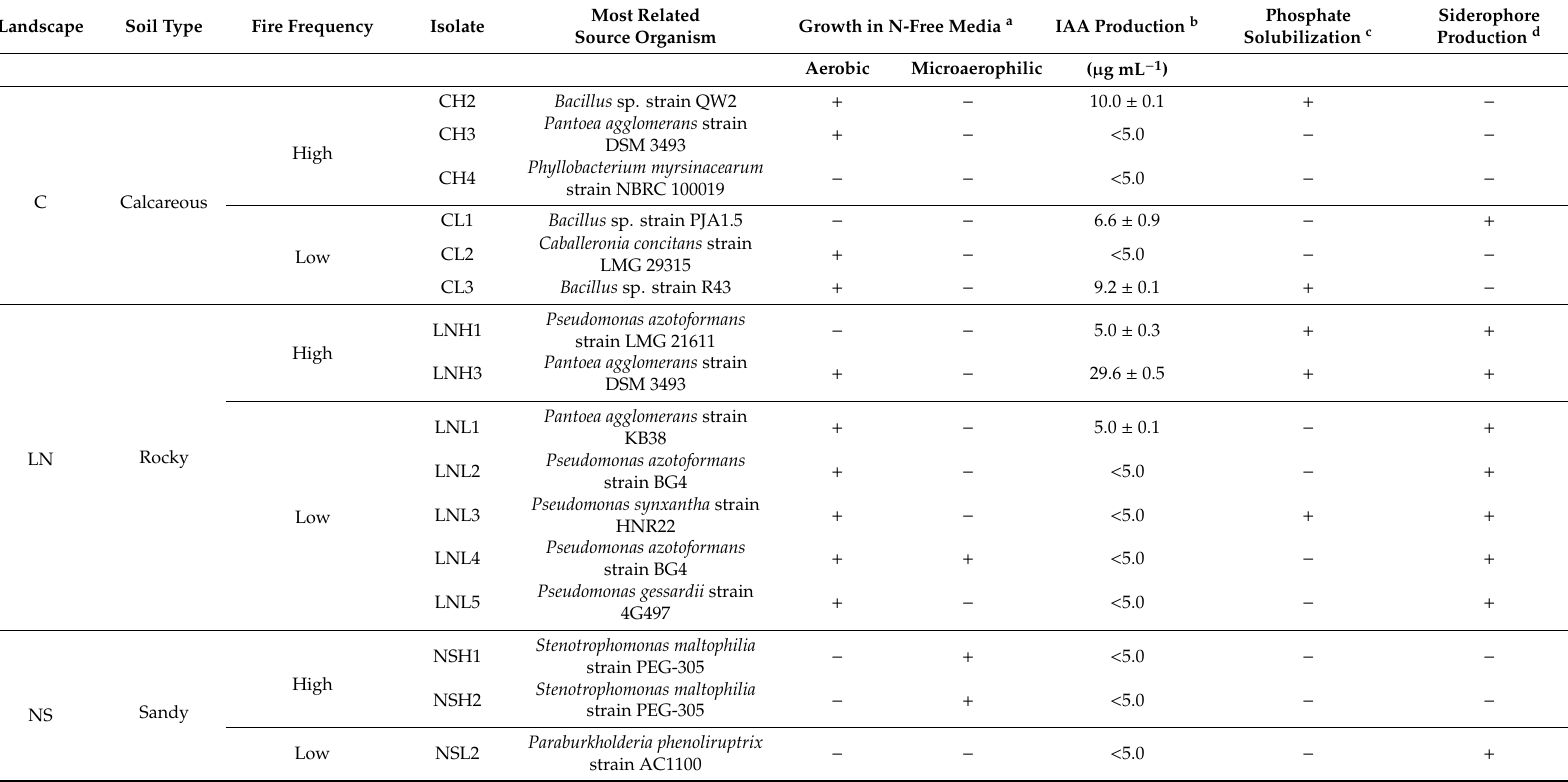
Table 4. In vitro plant-growth-promoting activities evaluated in soil isolates. Population codes follow Table 1.